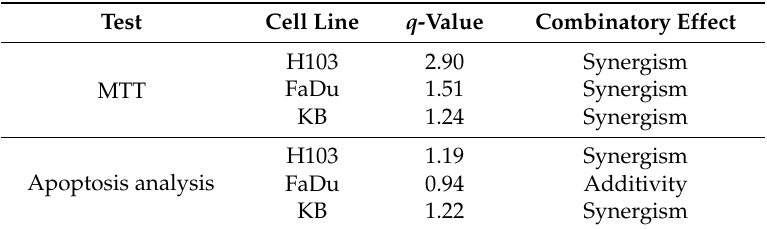
Table 1. Analysis of drug combinatory effect.